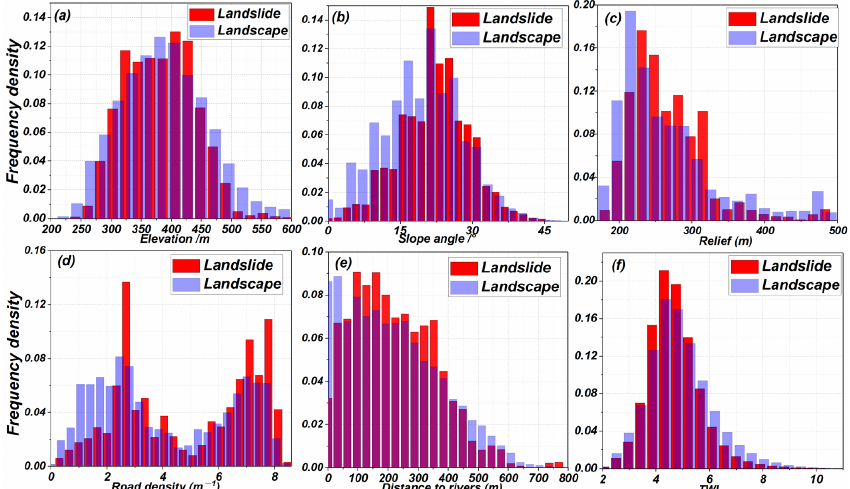
Figure 13. Frequency density estimates of landslides and landscape area for different influencing factors; ( a ) slope angle; ( b ) elevation; ( c ) relief; ( d ) road density; ( e ) distance to rivers; ( f )